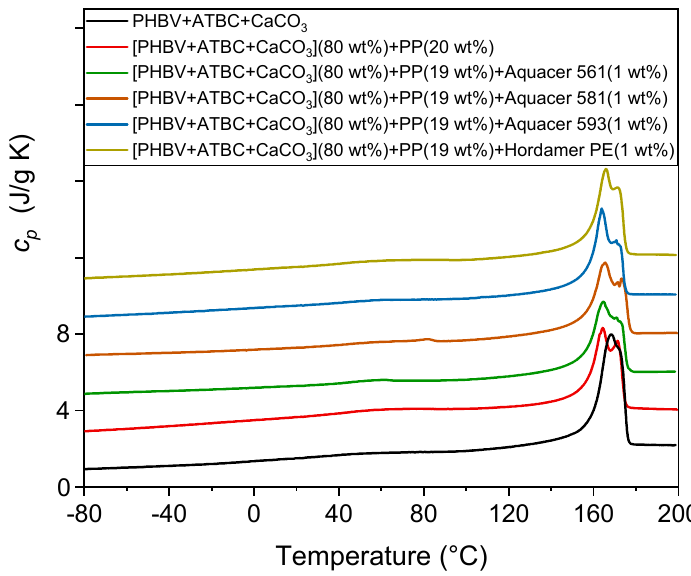
Figure 5. Specific heat capacity ( c p ) of the PHBV matrix and biocomposites indicated in the legend. The curves were obtained upon heating at 10 K/min after previous fast cooling to − 85 ◦ C. The ordinate values refer only to the bottom curve. All the other curves are shifted vertically for the sake of clearness.